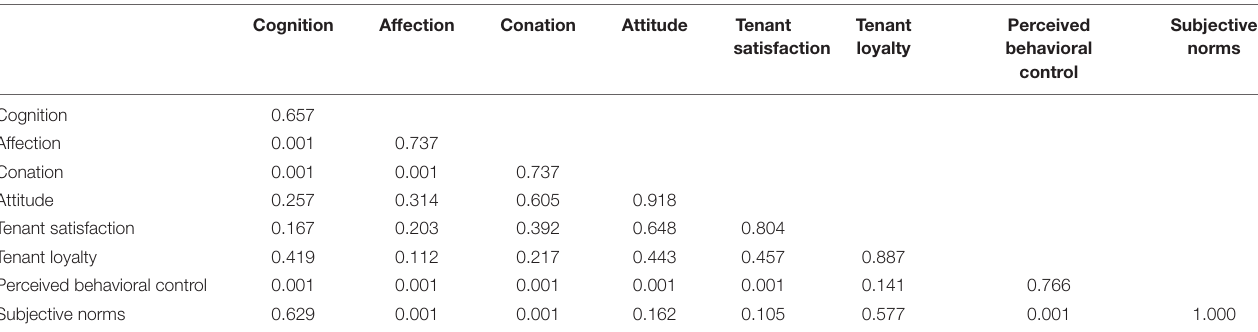
TABLE 3 | Correlation matrix of the latent